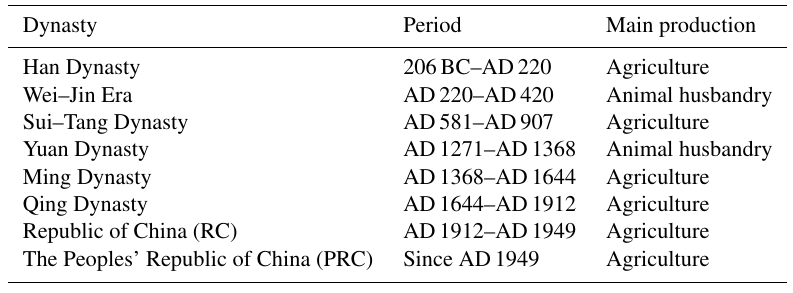
Table 1. Major dynasties during the selected study period (Lu et al., 2015c).